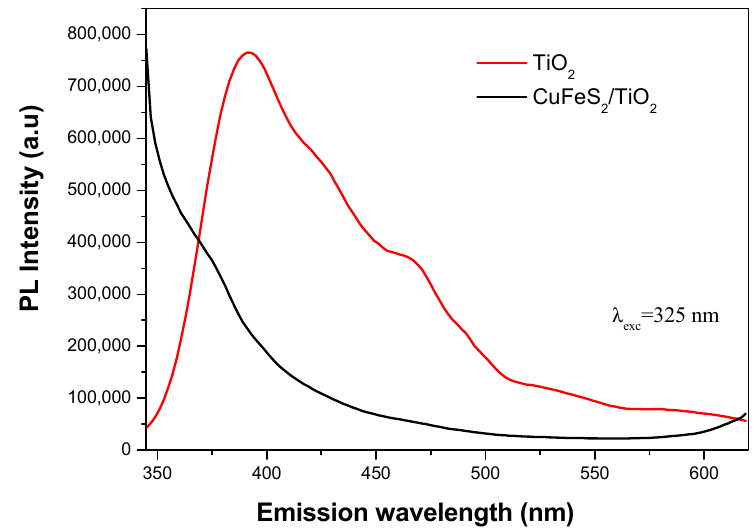
Figure 7. PL spectra of TiO 2 and CuFeS 2 /TiO 2 nanocomposite.